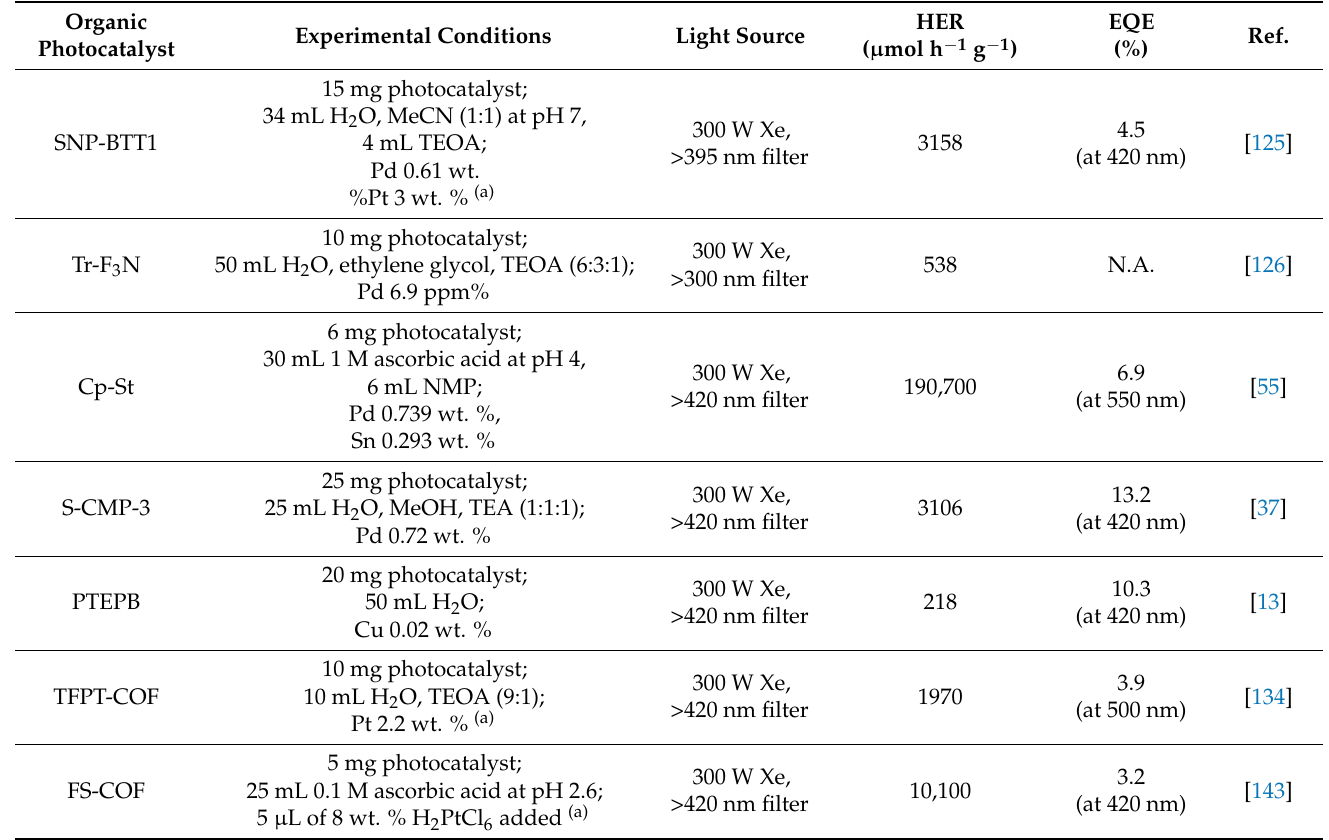
Table 2. Comparison of photocatalytic activity associated involving materials with relatively large internal surface